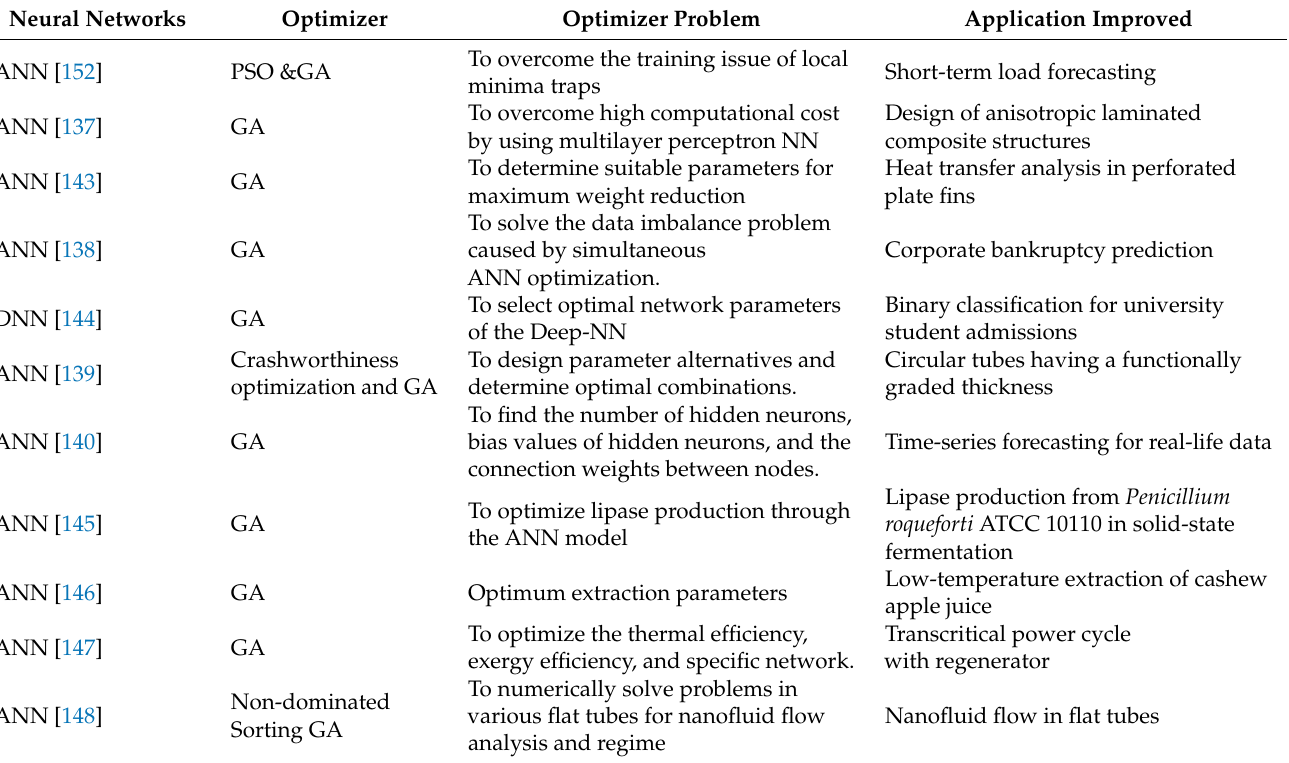
Table 4. Studies involving GA for neural network design and application enhancement. Neural